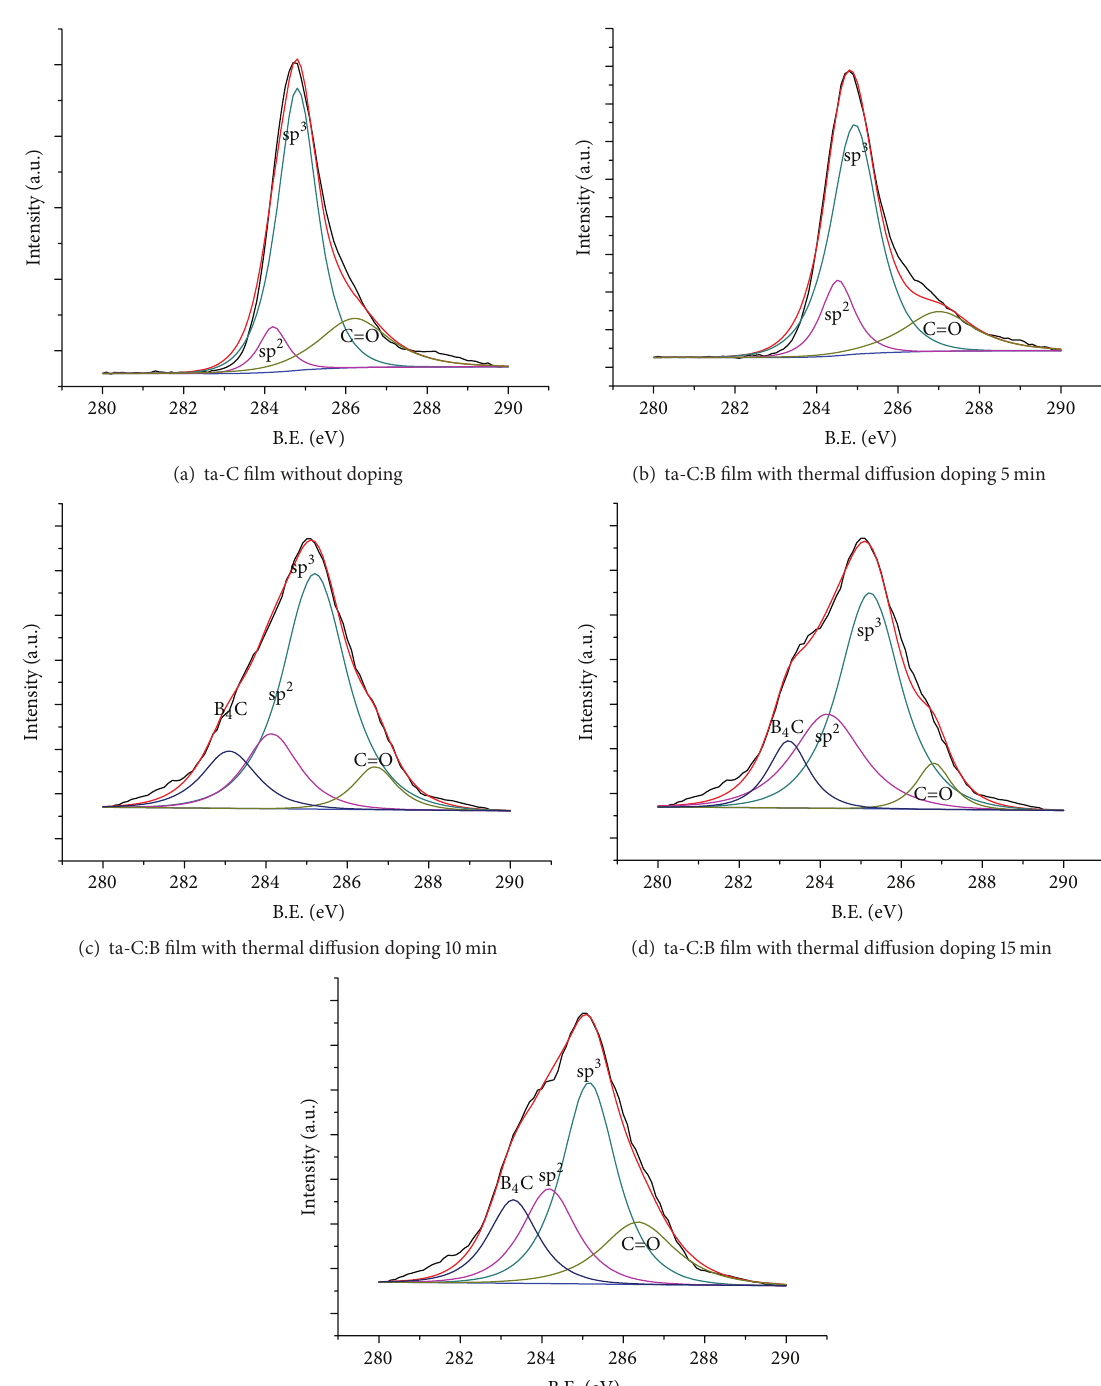
Figure 2: Fitting curve of C1s energy level spectrogram of ta-C film before and after boron doping.